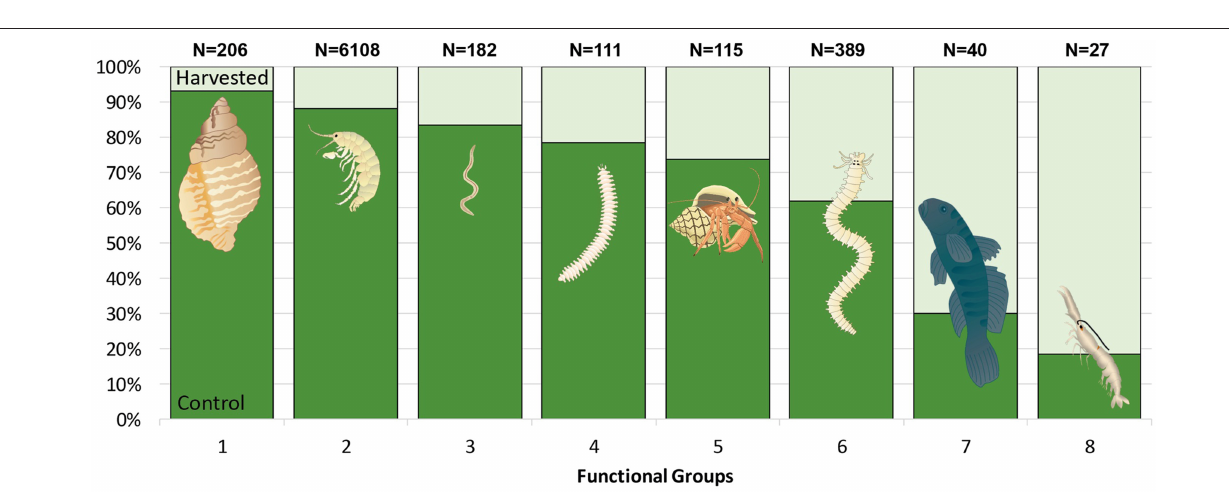
may determine the spatial extent of seagrass beds (Kneer et